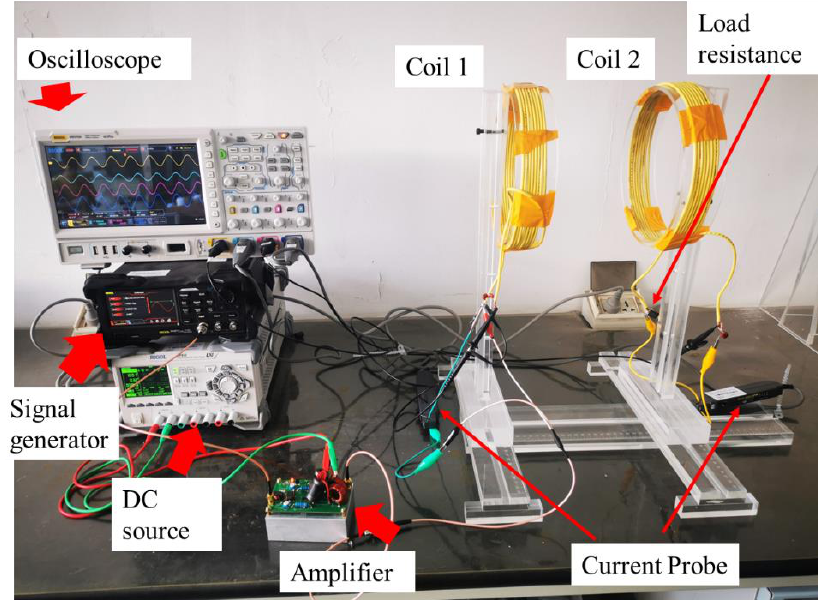
Figure 14. The two-coil WPT system in the experimental stage.